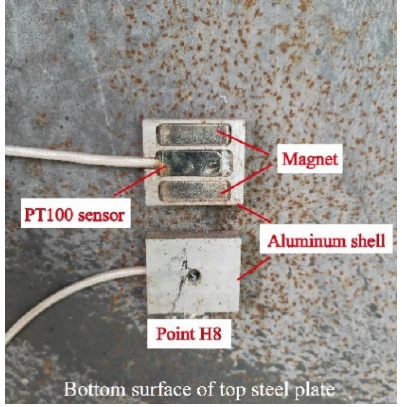
Figure 5. The exterior sensor with an aluminum square